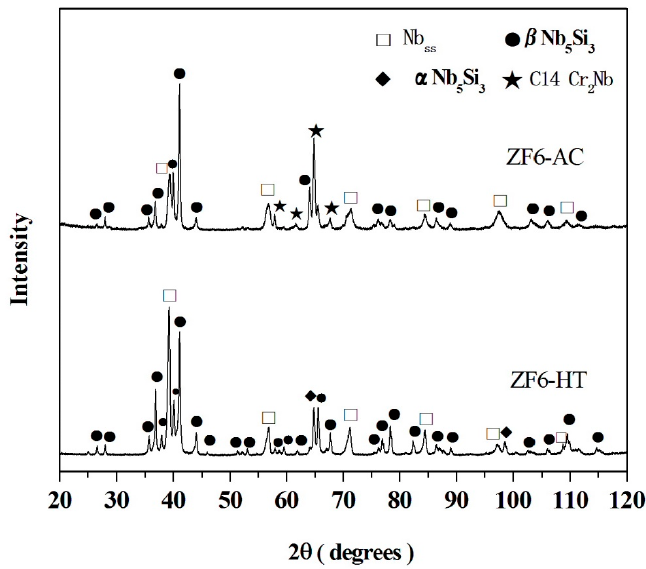
Figure 1. X-ray di ff ractograms of the as cast and heat treated (1400 ◦ C / 100 h) alloy Figure 1. X-ray diffractograms of the as cast and heat treated (1400 °C/100 h) alloy ZF6.